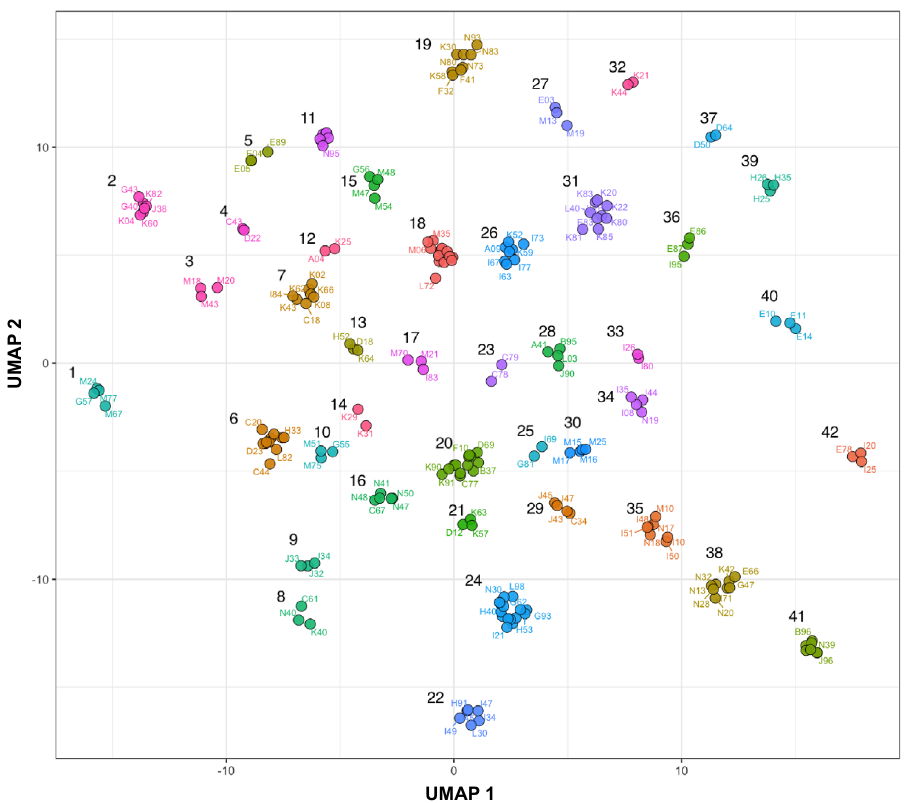
Figure 4. UMAP projection of the disease-biochemistry space. Diseases are projected into low-dimensionality space based on a similarity in biomarker hazard profiles. DBSCAN identified 42 distinct disease clusters. A detailed description of clusters can be found in Supplemental Table